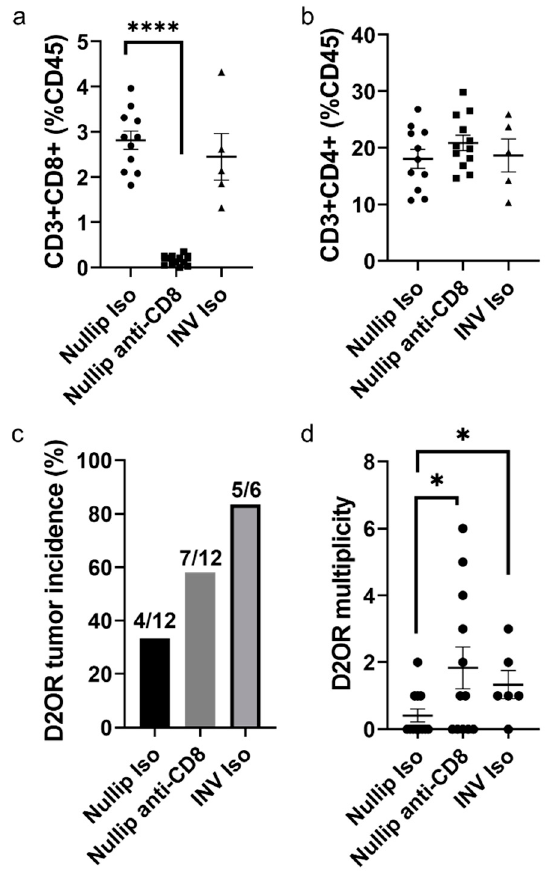
Figure 6. Depletion of CD8+ T cells in the nulliparous host recapitulates the involution metastatic advantage. Flow cytometry quantification of ( a ) CD8 and ( b ) CD4 T cells from livers of mice at endpoint of 6 week metastases study where mice were treated with CD8-depleting or isotype control antibody demonstrating effective CD3+CD8+ T cell depletion; ( c ) Incidence and ( d ) multiplicity of D2.OR liver metastases 6 weeks after intraportal injection of 50,000 D2.OR tumor cells with and without CD8 depletion in nulliparous hosts. Nullip iso n = 12, Nullip anti-CD8 n = 12, INV iso n = 6. One-way ANOVA. * p < 0.05, **** p < 0.0001.